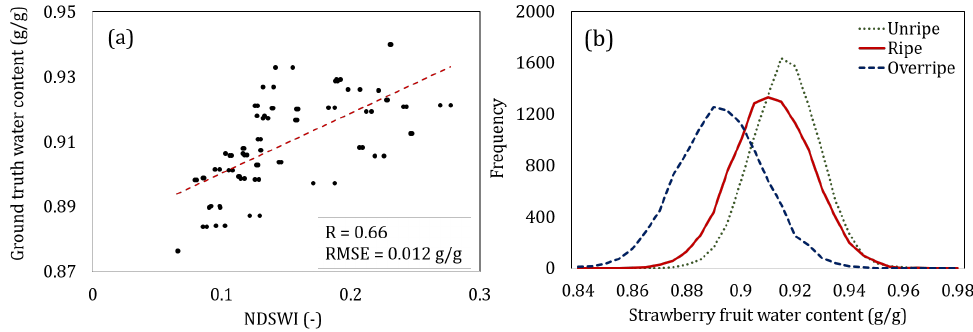
Figure 8. ( a ) Scatter plot between NDSWI and ground truth strawberry water content. ( b ) Histogram of unripe, ripe, and overripe strawberry fruits water content